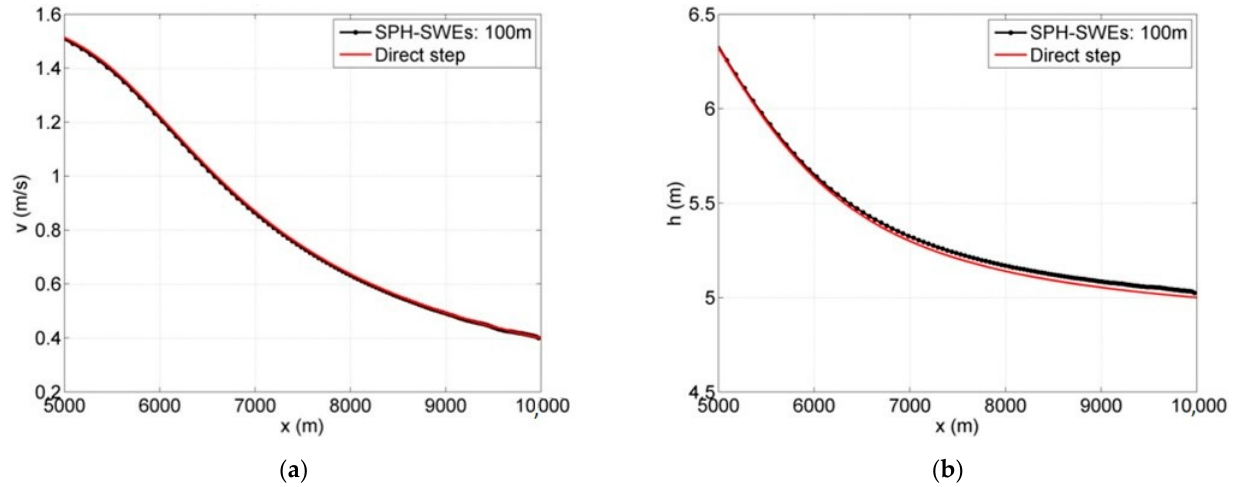
Figure 4. Results of 1D simulation for M1 curve longitudinal profile: ( a ) velocity and ( b ) water level.